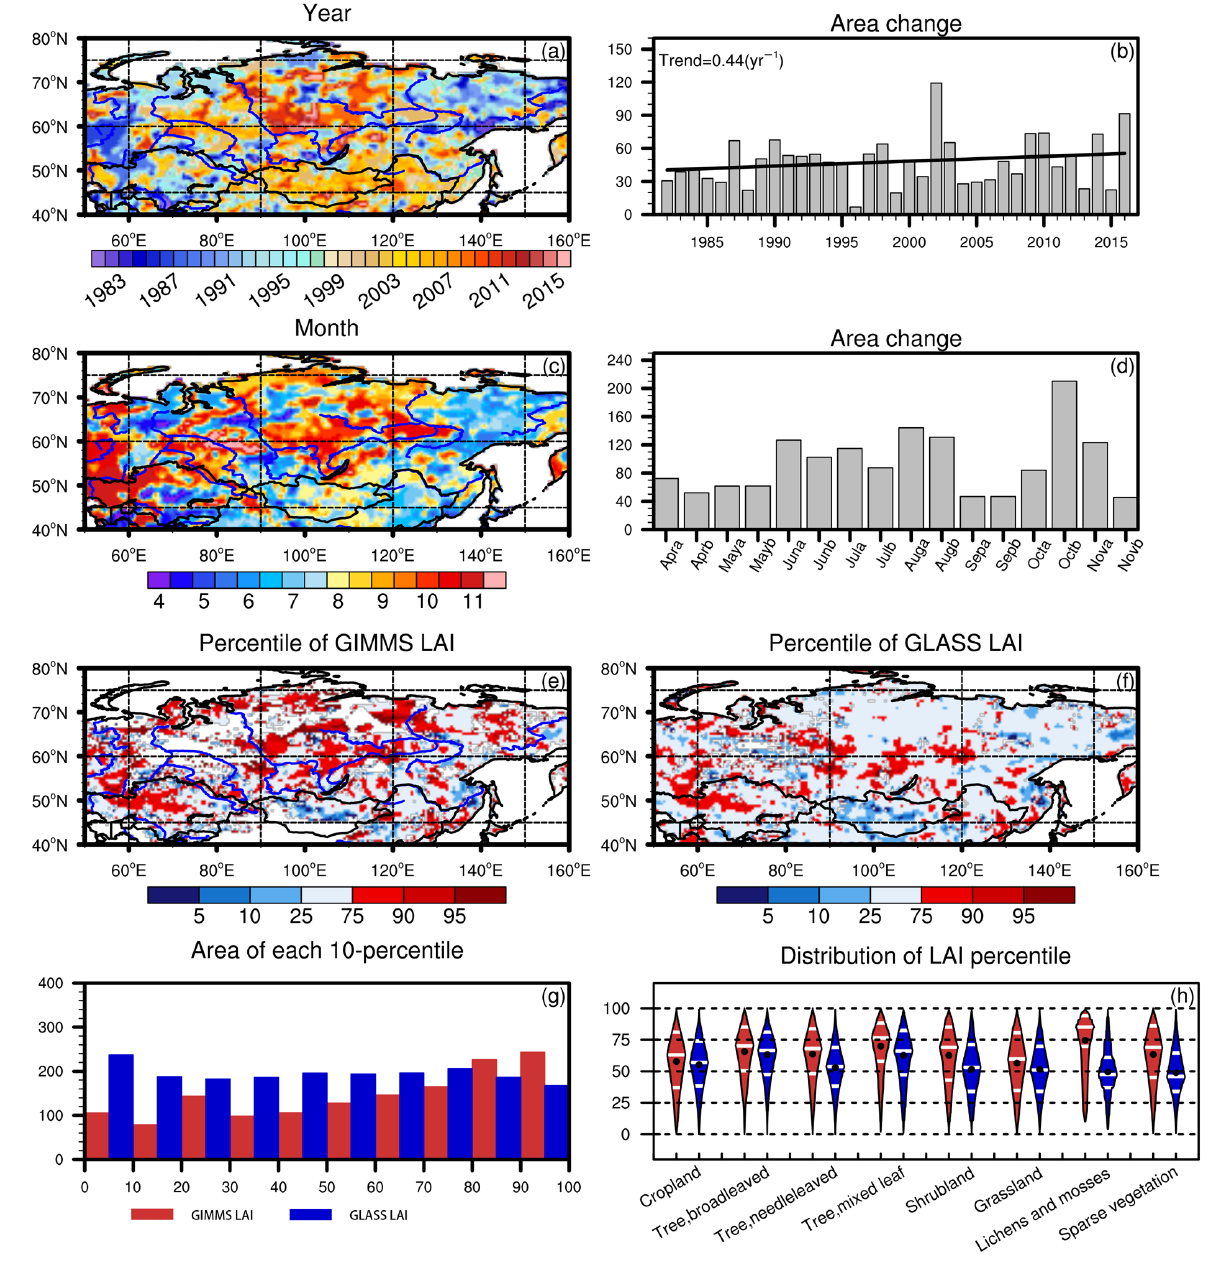
Figure 6. Same as Figure 5 but for the LAI when the minimum 2 m temperature was recorded. Years ( a ), half-months ( c ), and percentiles of GIMMS LAI ( e ) and GLASS LAI ( f ) when the minimum 2 m temperature was recorded, and the corresponding accumulated areas (unit in 10 4 km 2 ( b , d , g )). The box plot ( h ) shows the percentile of the LAI for different vegetation types, with the white lines showing the 25th, 50th, and 75th percentiles, and the dots showing the averages. The line in b is the linear trend calculated by least-squares